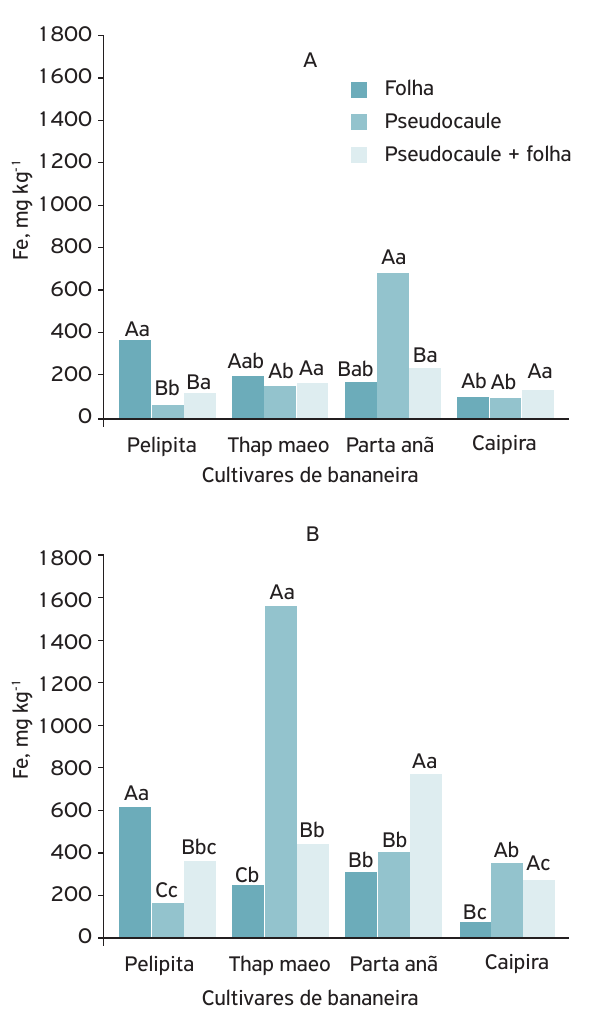
Figura 4. Teores de Mn, mg kg -1 , presente no substrato à base de resíduos de bananeira (pseudocaule, folha e pseudocaule + folha) de quatro cultivares de bananeira (Thap maeo, Prata anã, Pelipita e Caipira) antes (A) e após 49 dias (B) de colonização pela linhagem 09/100 de Pleurotus ostreatus . Letras maiúsculas comparam médias dentro de um mesmo cultivar de bananeira; letras minúsculas comparam médias dentro de cada tipo de resíduo. Médias seguidas de letras iguais não diferem entre si (Tukey, 5%) (Média de duas